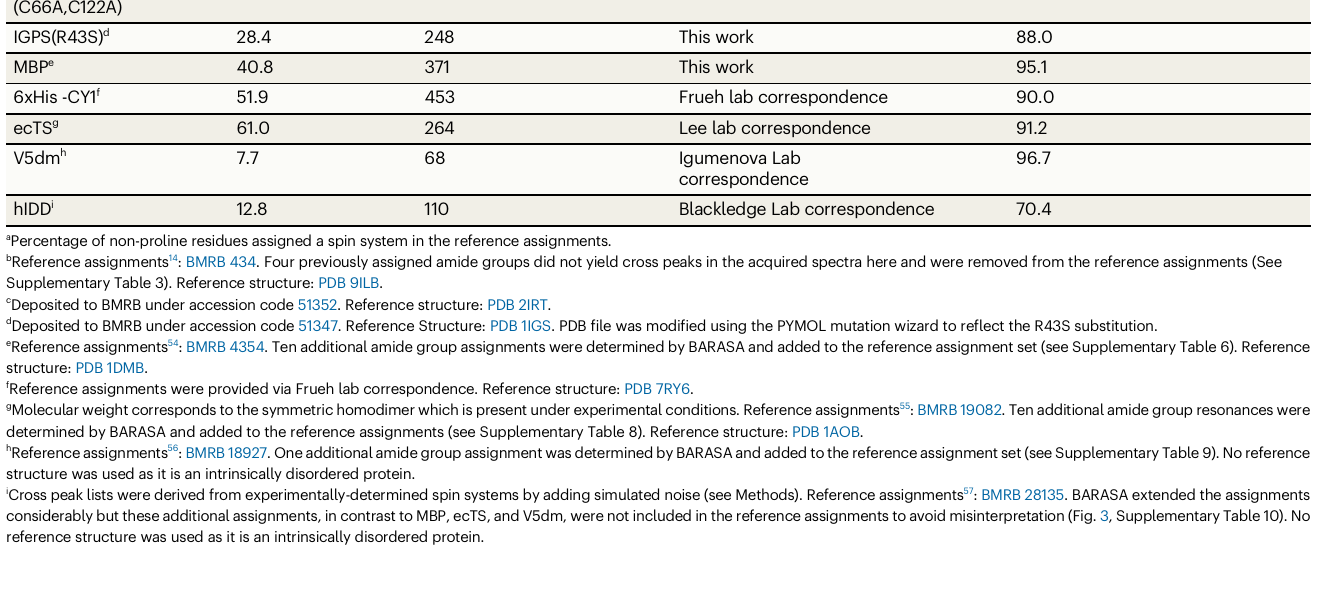
Table 1 | Proteins employed to evaluate BARASA